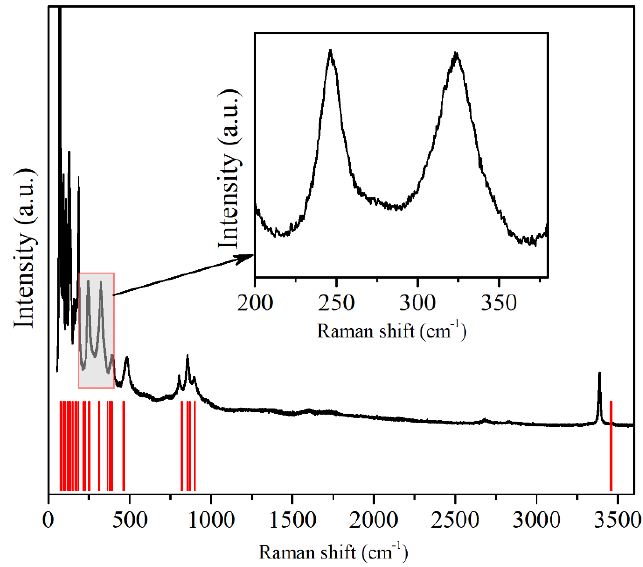
Figure 6. The typical Raman scattering spectra of Cu(OH)Cl at ambient pressure. The vertical lines represent the calculated locations of the Raman-active modes.